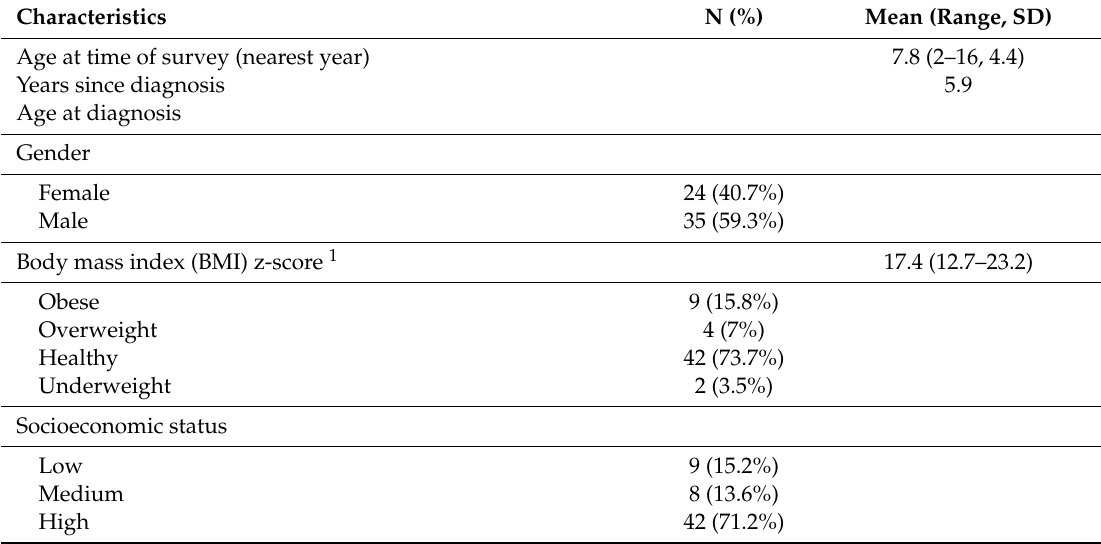
Table 1. General demographic characteristics of the present